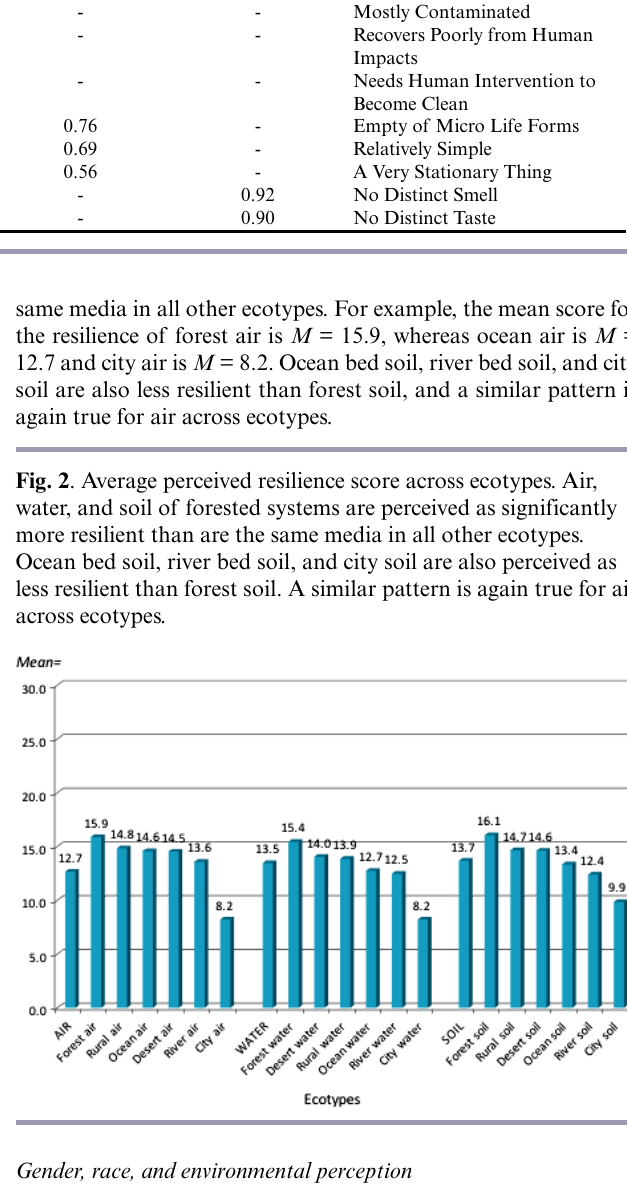
Gender, race, and environmental